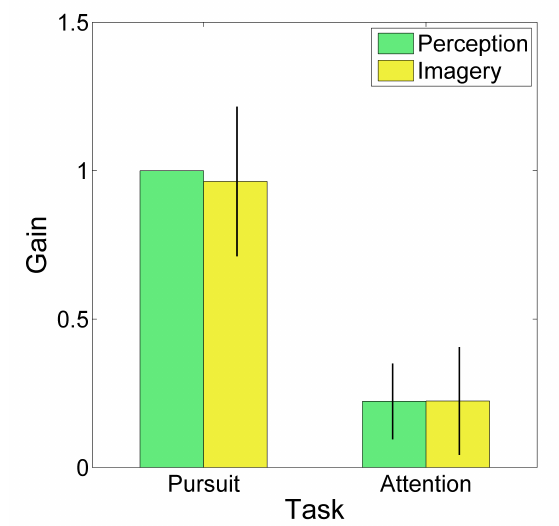
Figure 4: Gain of cSSVEP modulation. Perception and Imagery are the second and third cycle, respectively. Bars represent the 99% confidence interval (in the perception cycle of Pursuit tracking there is no bar because the gain is 1 by